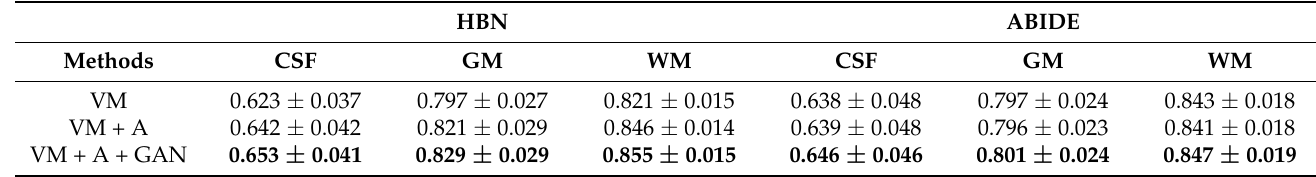
Table 3. Dice indicator based on deep learning. Bold numbers indicate the best results. HBN ABIDE